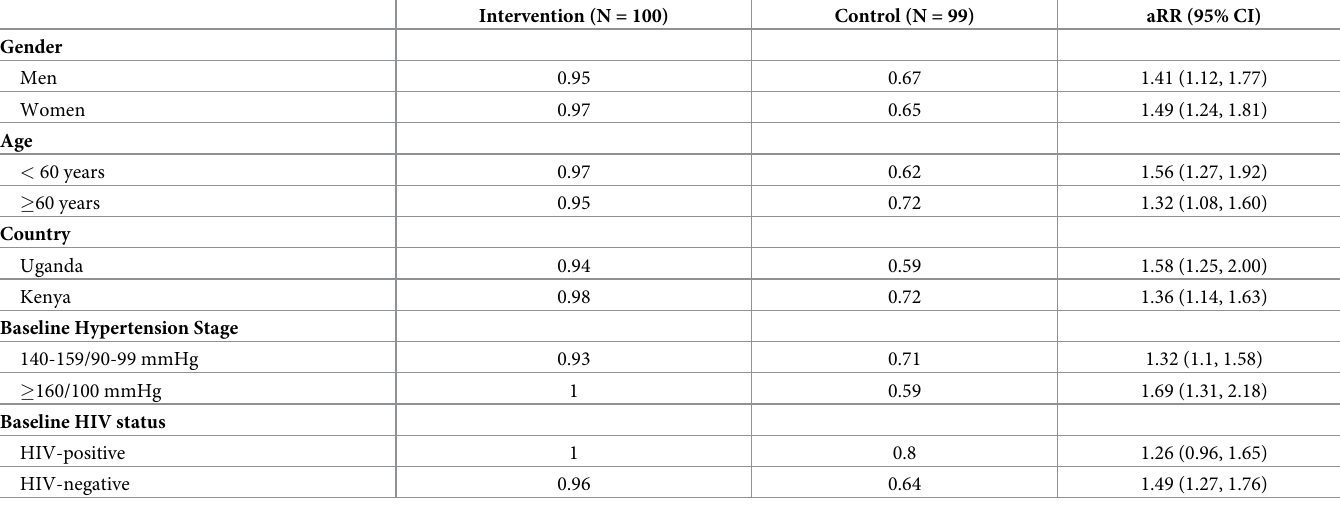
Table 3. Linkage to care within 30 days, stratified by baseline participant